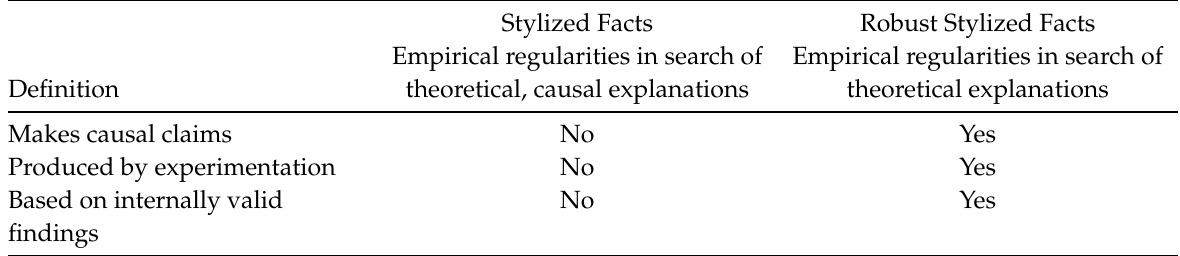
Table 1: Conceptualization of stylized